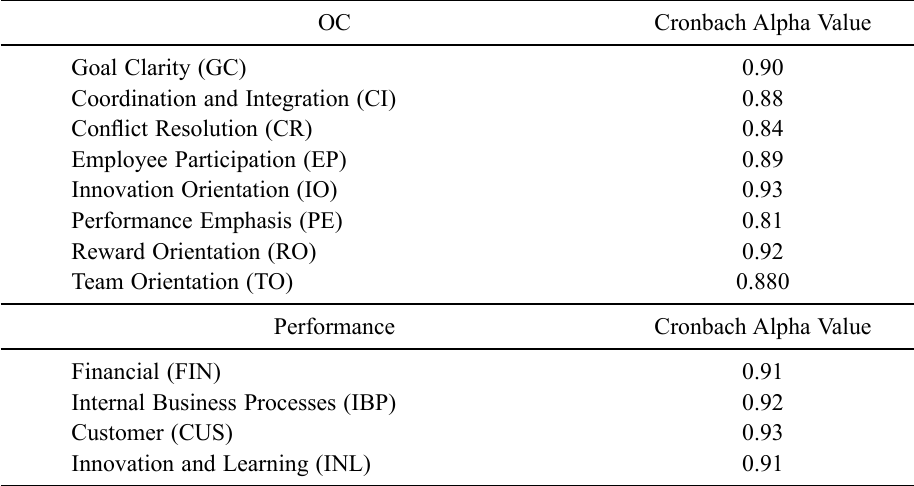
Table 4. Results of Cronbach alphas reliability